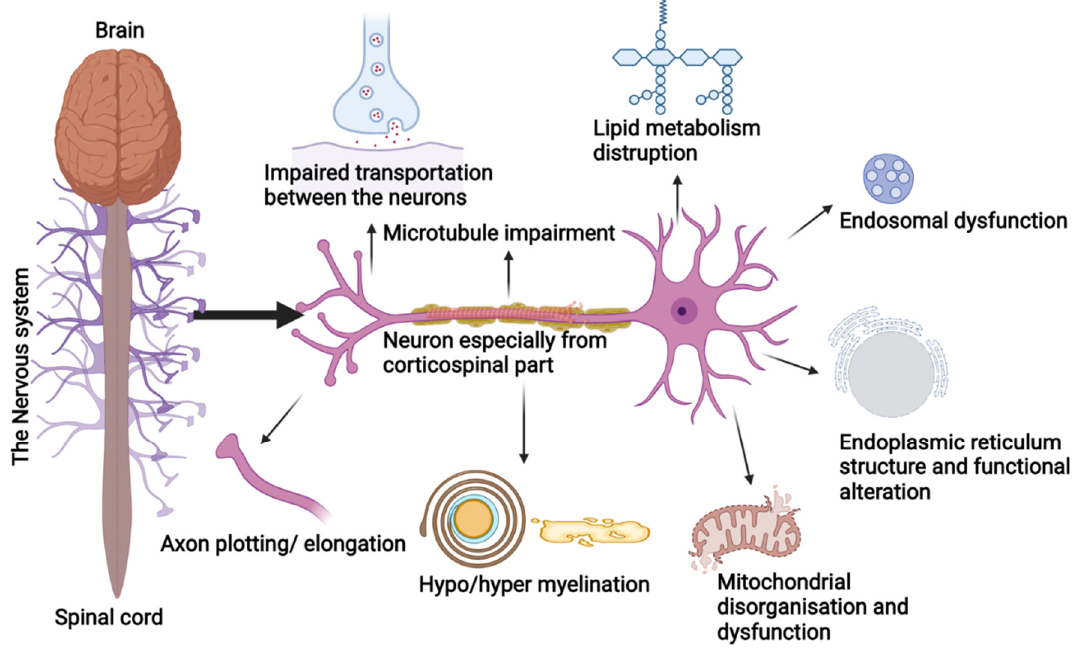
Figure 2. Schematic representation of the cellular process involved in the pathology of HSP.